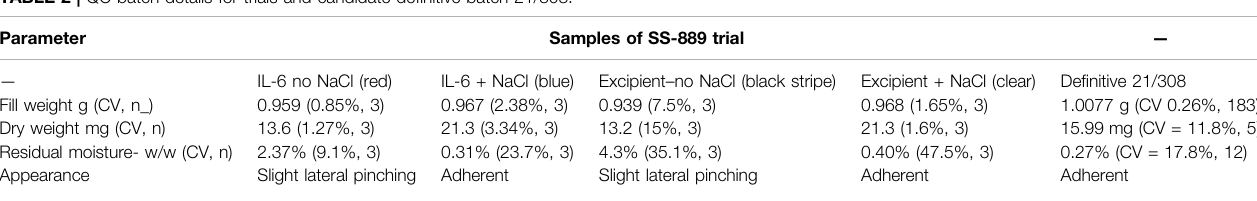
TABLE 2 | QC batch details for trials and candidate de fi nitive batch 21/308.